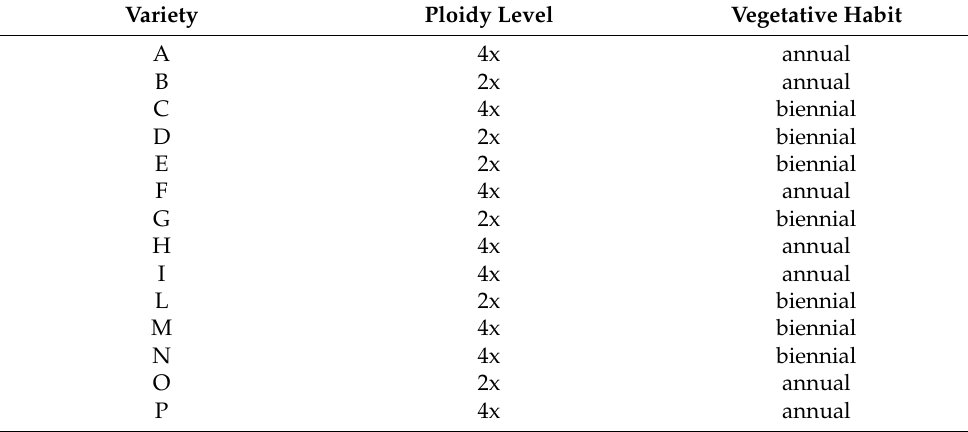
Table 1. Plant material information, including variety code, relative ploidy level, and vegetative habit.